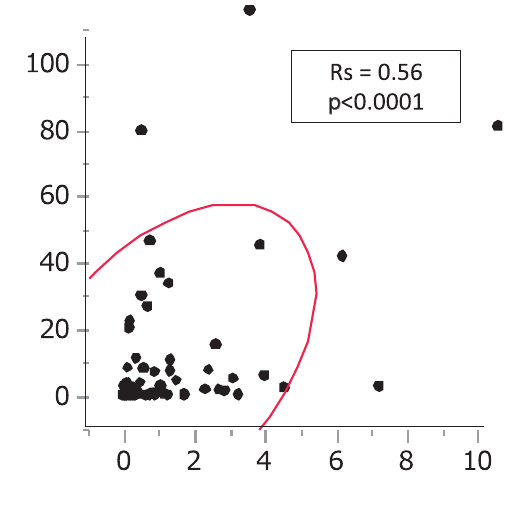
Figure 2. Relation of AREG and EREG expression. AREG and EREG expression values were significantly correlated (Rs = 0.56, p<0.0001)